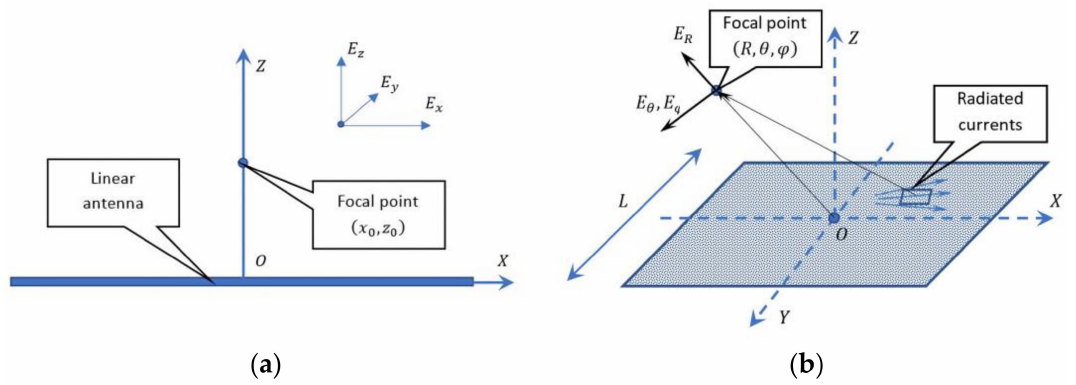
Figure 2. Linear ( a ) and planar ( b )